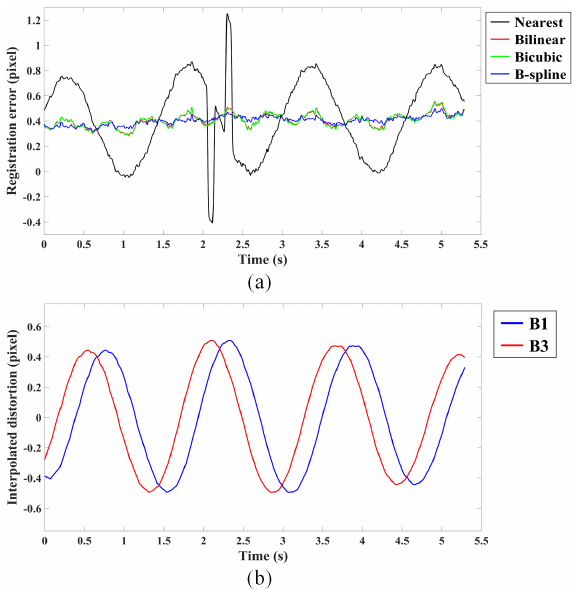
Figure 8. a) The registration errors between the compensated bands using different interpolators and b) the interpolated distortions on two bands in the along-track direction.